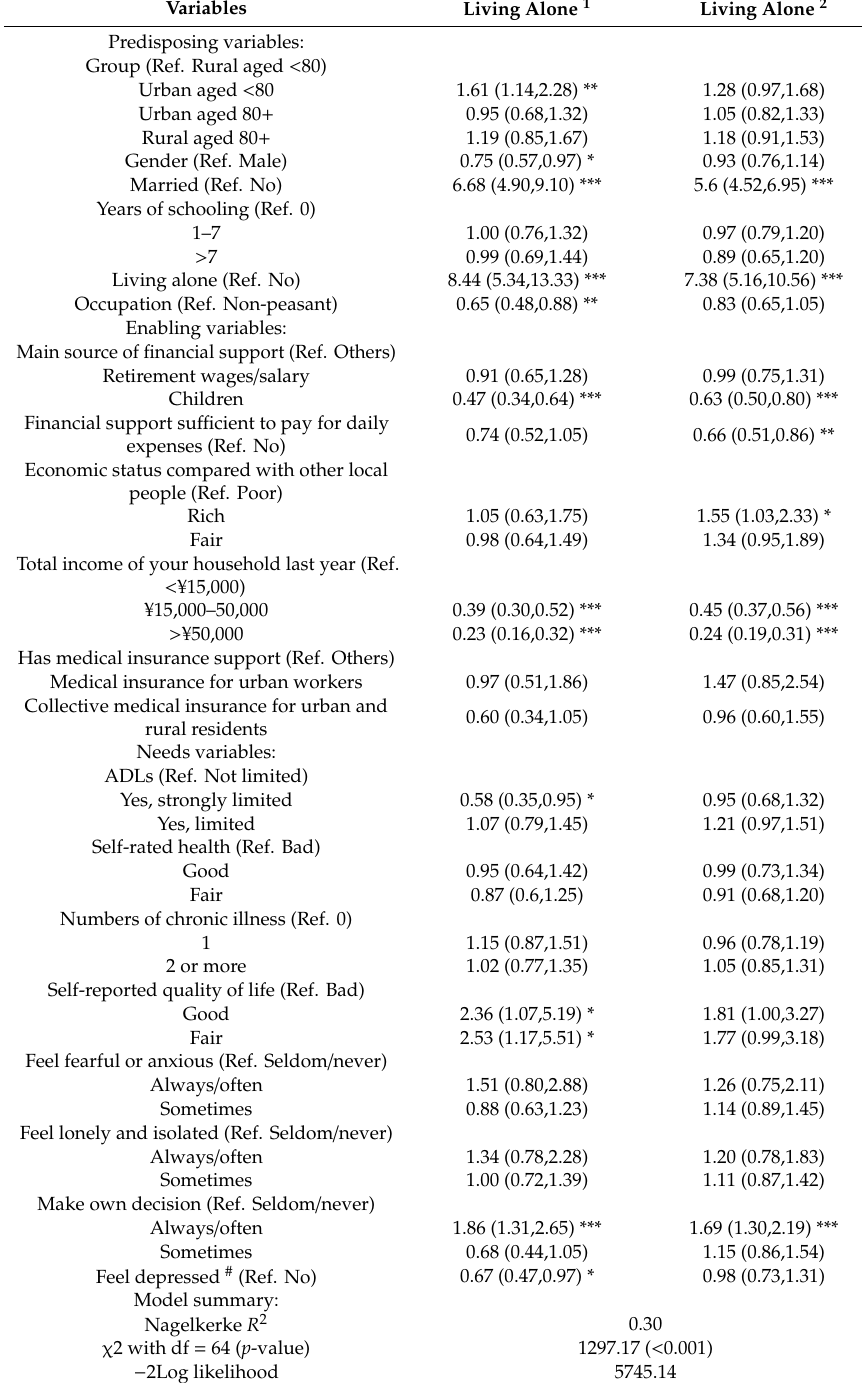
Table 5. Odds ratios of anticipated living arrangements (multinomial logistic